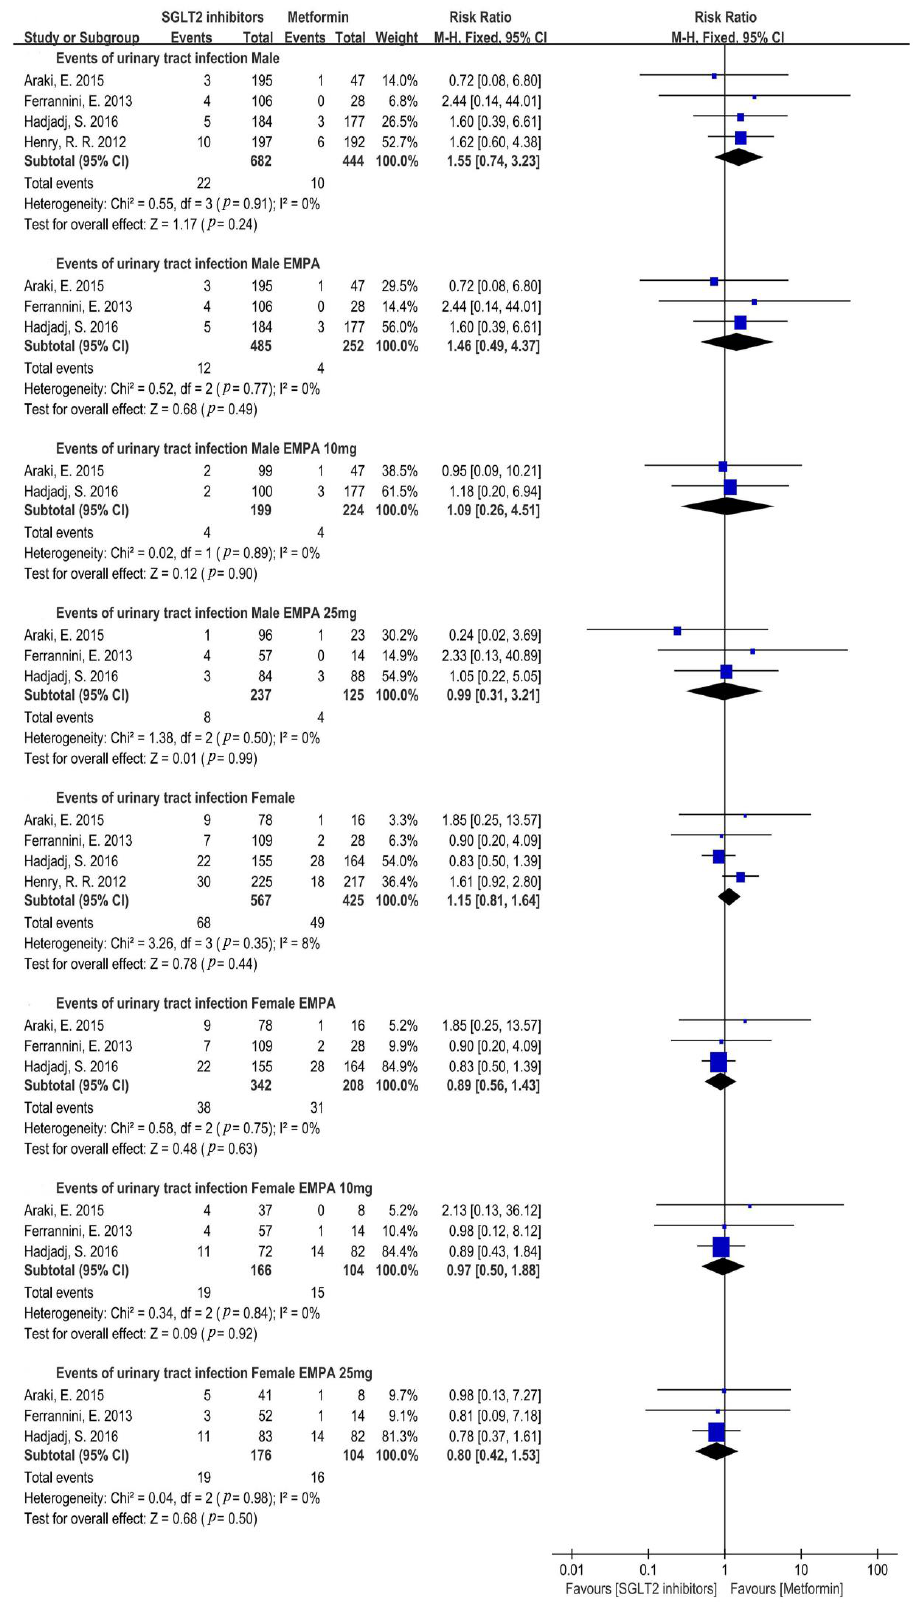
Figure 7. Risk of urinary tract infections with different types and doses of SGLT2i compared with that of metformin in male and female patients [20,22–24]. EMPA =